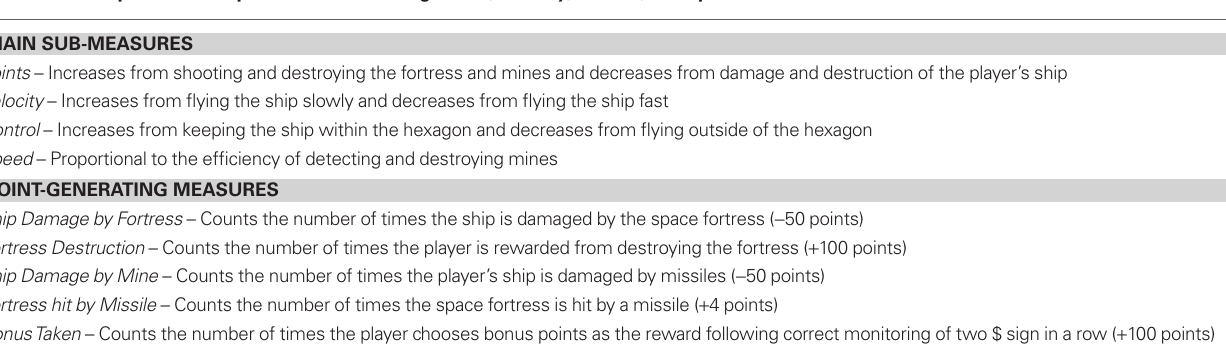
Table 2 | A description of each measure obtained from the space fortress game.